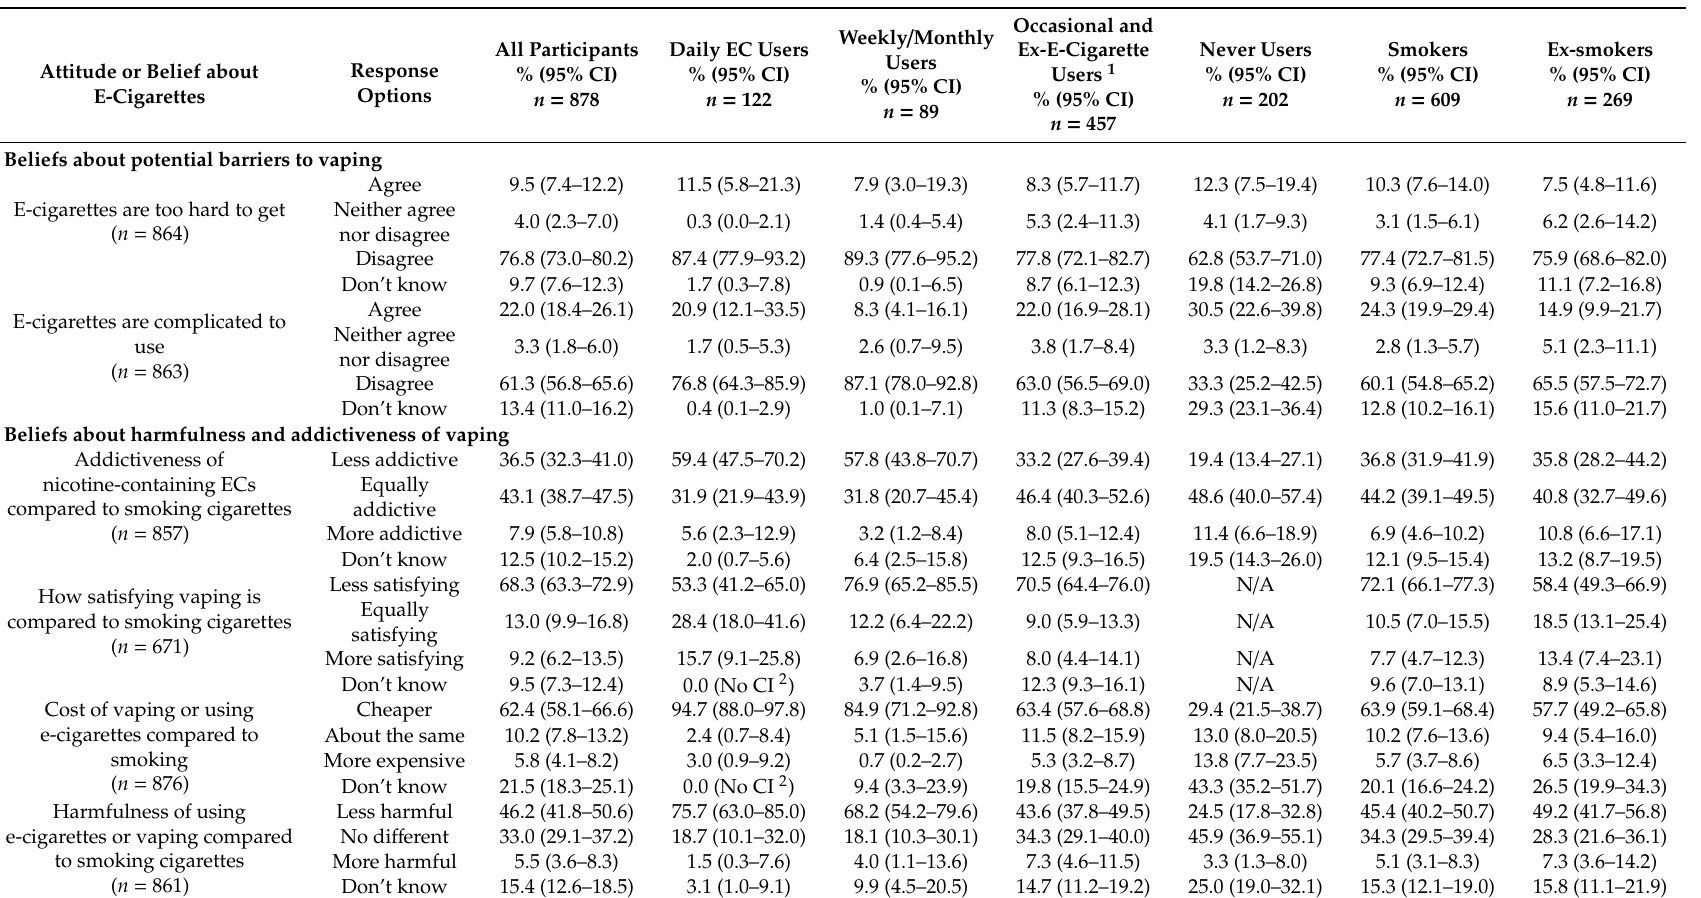
Table 5. Attitudes and beliefs about e-cigarettes among Wave 2 participants aware of e-cigarettes, stratified by history and frequency of e-cigarette use and smoking